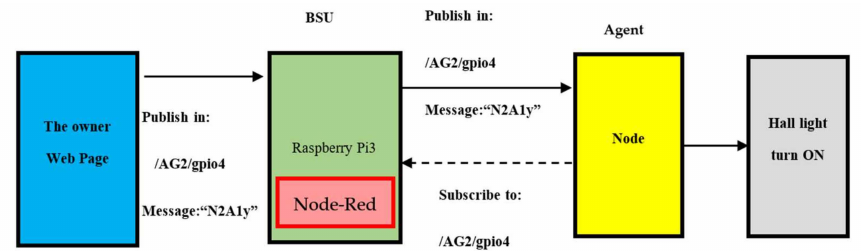
Figure 3. Proposed simulation Internet of Energy platform